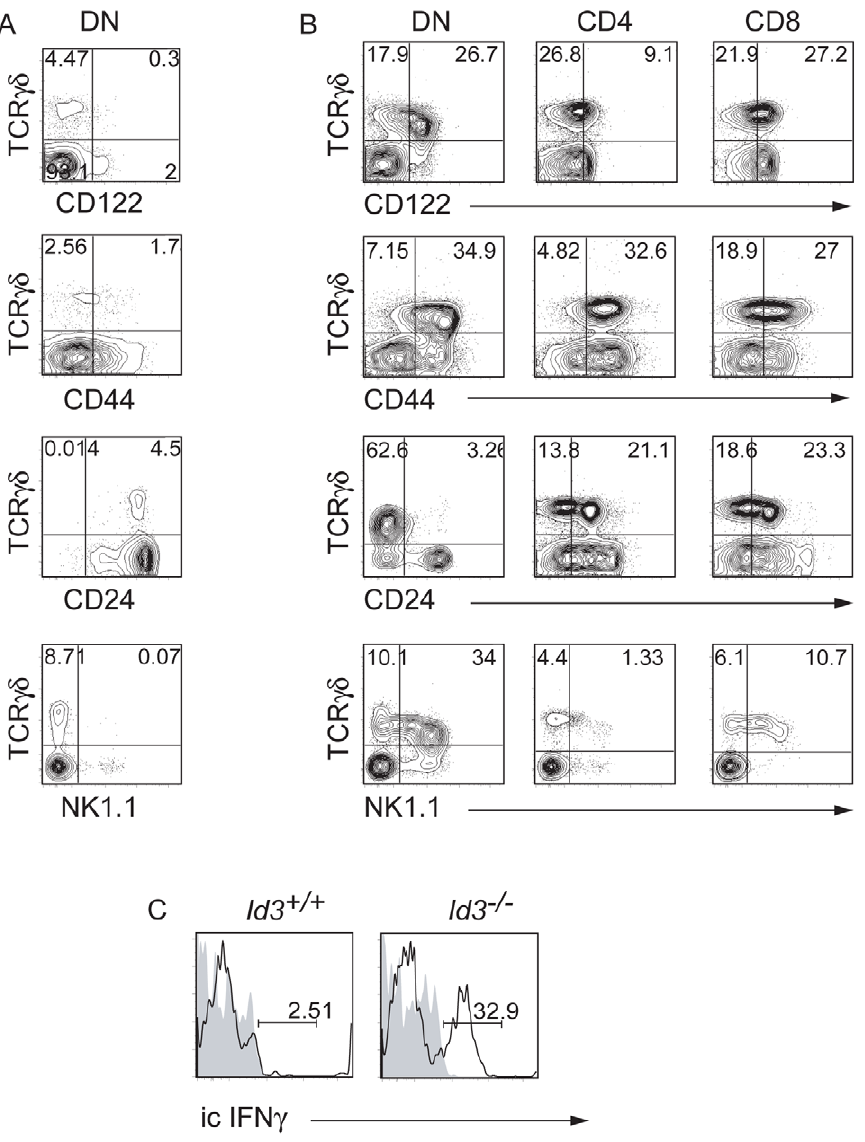
Figure 2. Id3 2 / 2 cd T cells have an activated phenotype. FACS analysis of Id3 + / + DN thymocytes (A) or Id3 2 / 2 DN, CD4 and CD8 thymocytes (B) for expression of TCR cd and CD122, CD44, CD24 or NK1.1. The analysis shows that Id3 2 / 2 cd T cells have markers of activation independent of expression of CD4 or CD8. Data are representative of . 10 experiments. C) FACS analysis showing intracellular staining for IFN c (open histogram) in Id3 + / + and Id3 2 / 2 TCR cd + thymocytes 5 hours after stimulation with PMA and ionomycin. Shaded histogram shows isotype control. One of 3 experiments is shown.